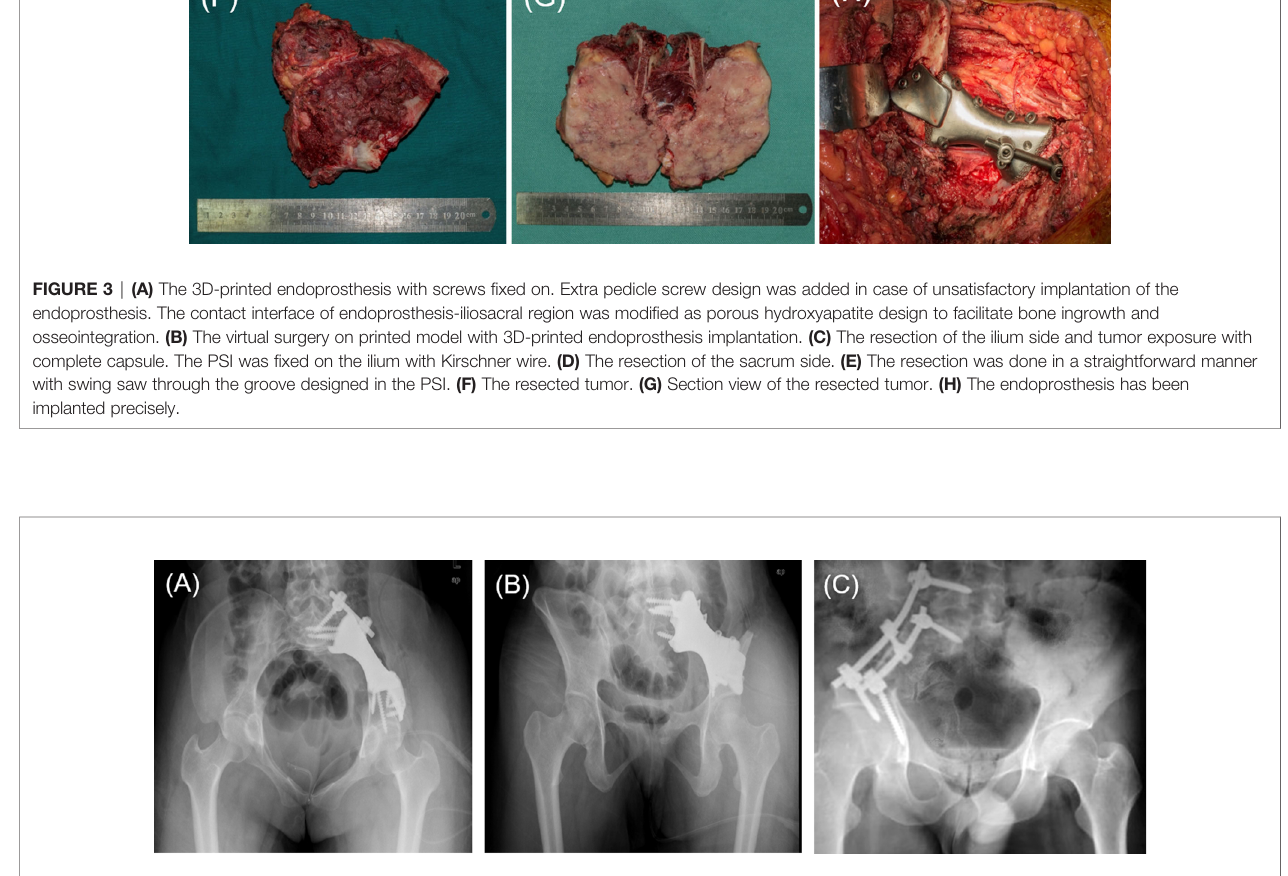
FIGURE 4 | (A, B) Anteroposterior view of postoperative plain fi lm of the patient underwent 3D-printed endoprosthesis. (C) An example of patient received pedicle screw-rod fi